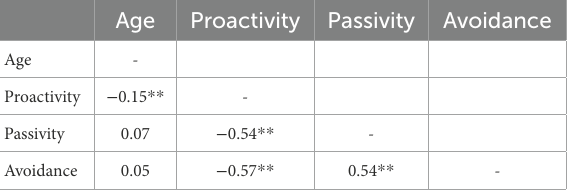
TABLE 6 Correlation between age and three level of actions ( n = 324).